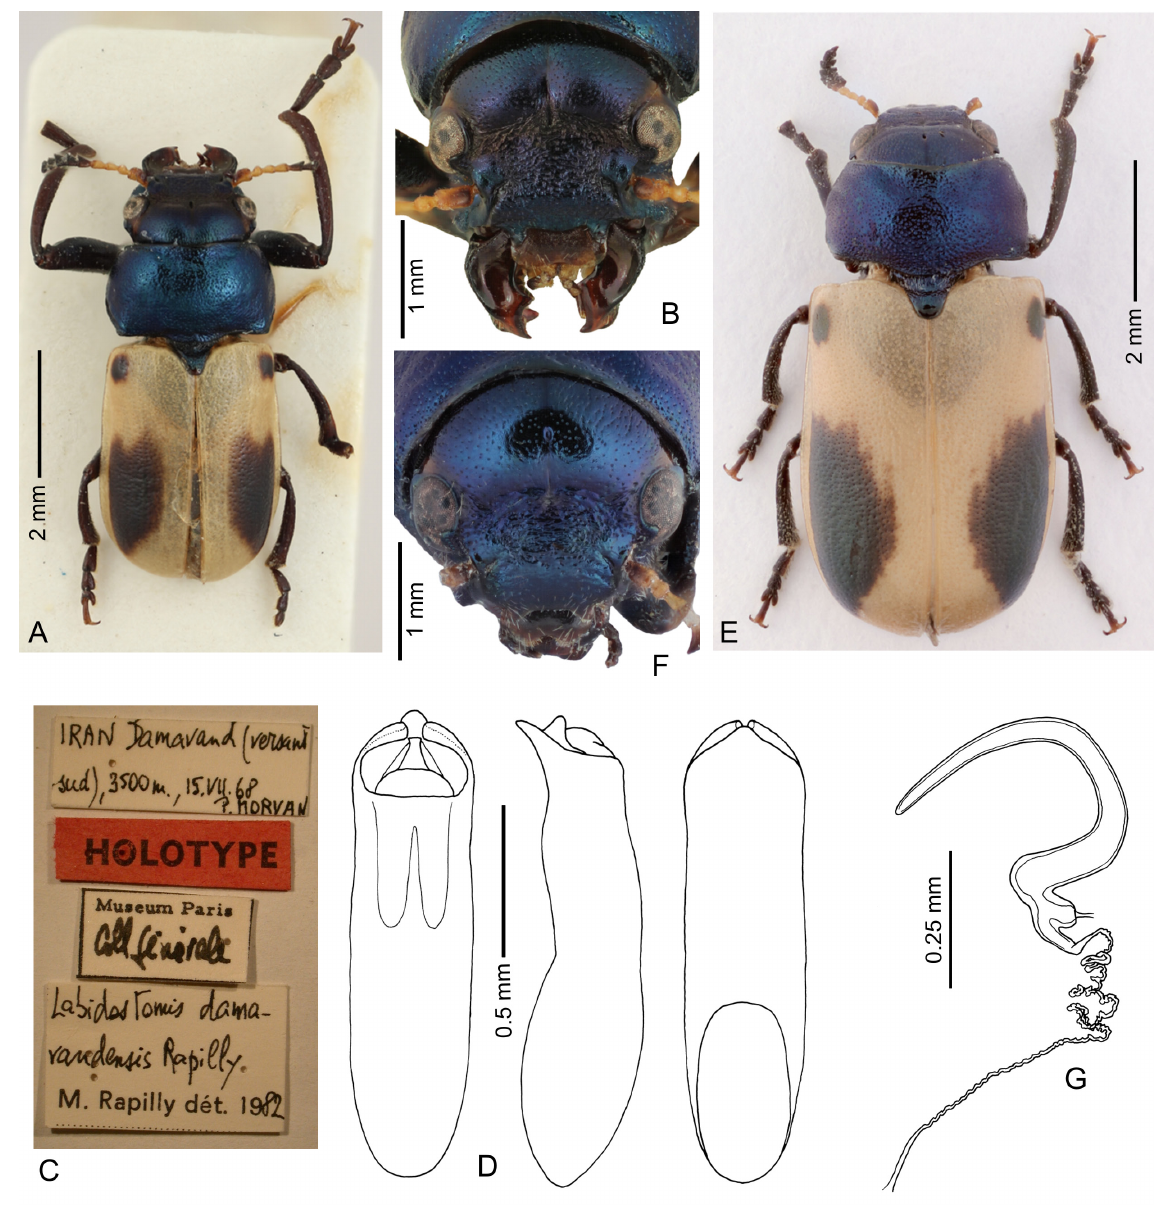
Fig. 2. Labidostomis damavandensis Rapilly, 1984. A – D . Holotype, ♂, 6.5 mm (MNHN). A . Dorsal view. B . Head. C . Labels. D . Aedeagus in dorsal, lateral and ventral views. E – G . ♀, 5.6 mm (NMPC). E . Dorsal view. F . Head. G .